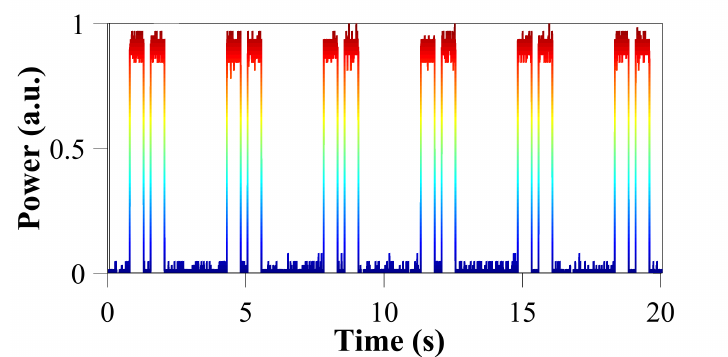
Figure 5. Multispike measurements generated from our system.